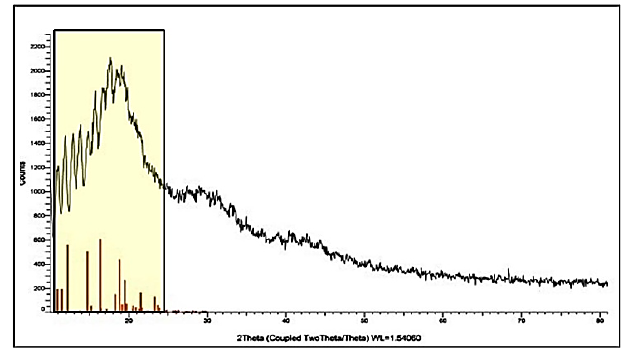
Figure 5. X-ray diffraction pattern of pumice rock.